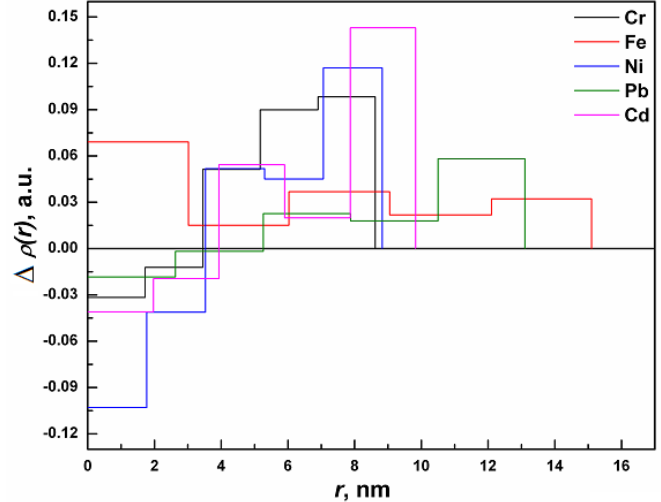
Figure 6. Resulting cross-section radial electron density profiles for GKG-metal